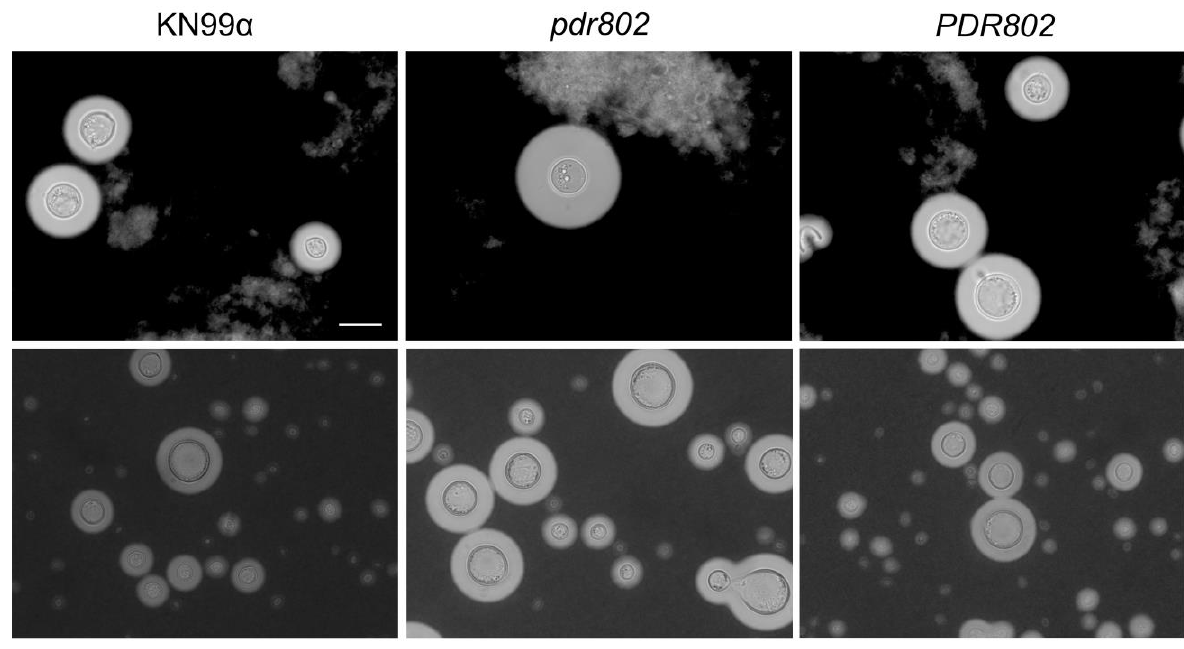
FIGURE 1: The transcription factor Pdr802 is a negative regulator of cryptococcal capsule thickness and Titan cell formation. Upper panel, India ink staining of fungal cells isolated from the lungs of mice infected with the wild- type (KN99α), deleted ( pdr802 ), and complemented ( PDR802 ) strains at 3 days post-infection. Lower panel, India ink staining of the same strains after growth in Titan cell induction media in vitro for 72 hours at 37°C and 5% CO 2 . All images are to the same scale; scale bar, 10